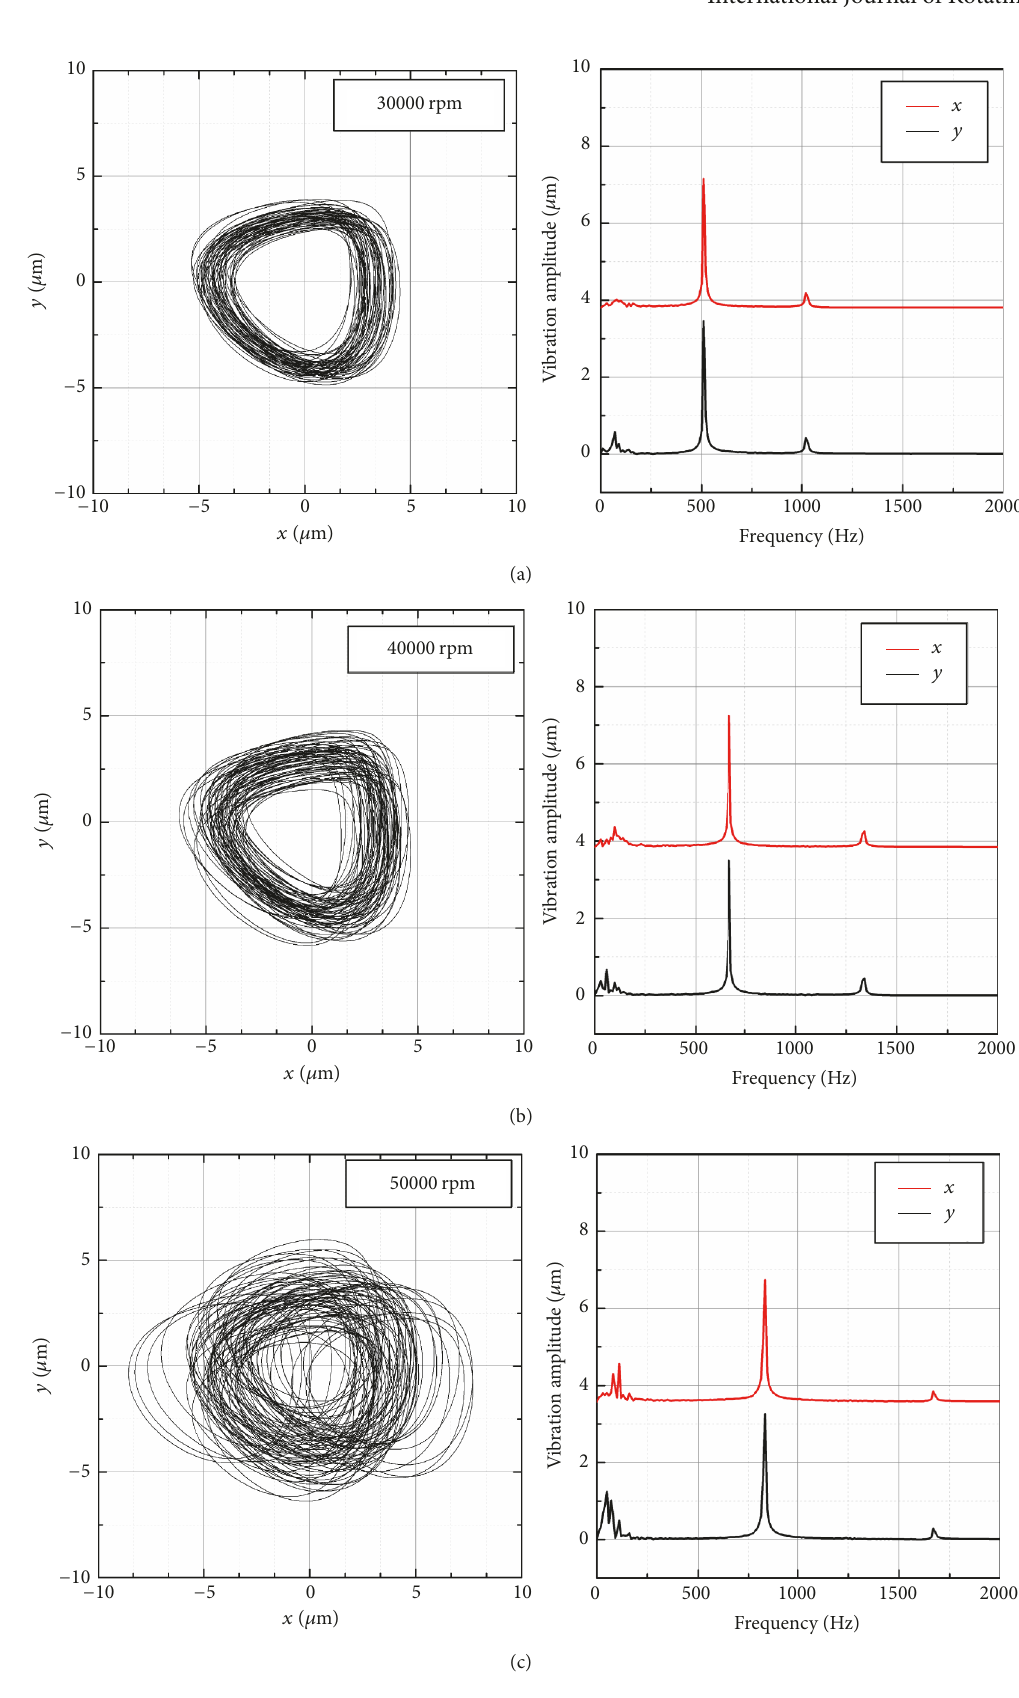
Figure 14: Rotor orbits and vibrations in 𝑋 and 𝑌 directions: (a) 30000 rpm; (b) 40000 rpm; (c) 50000